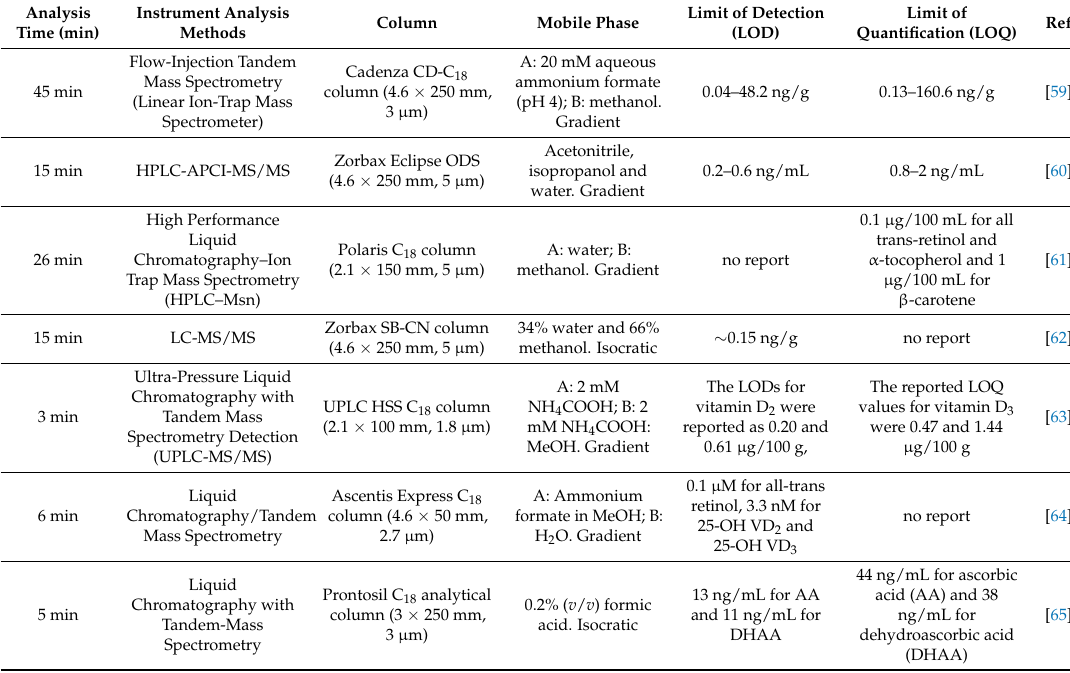
Table 4. Examples of HPLC-MS/MS methods for the detection of